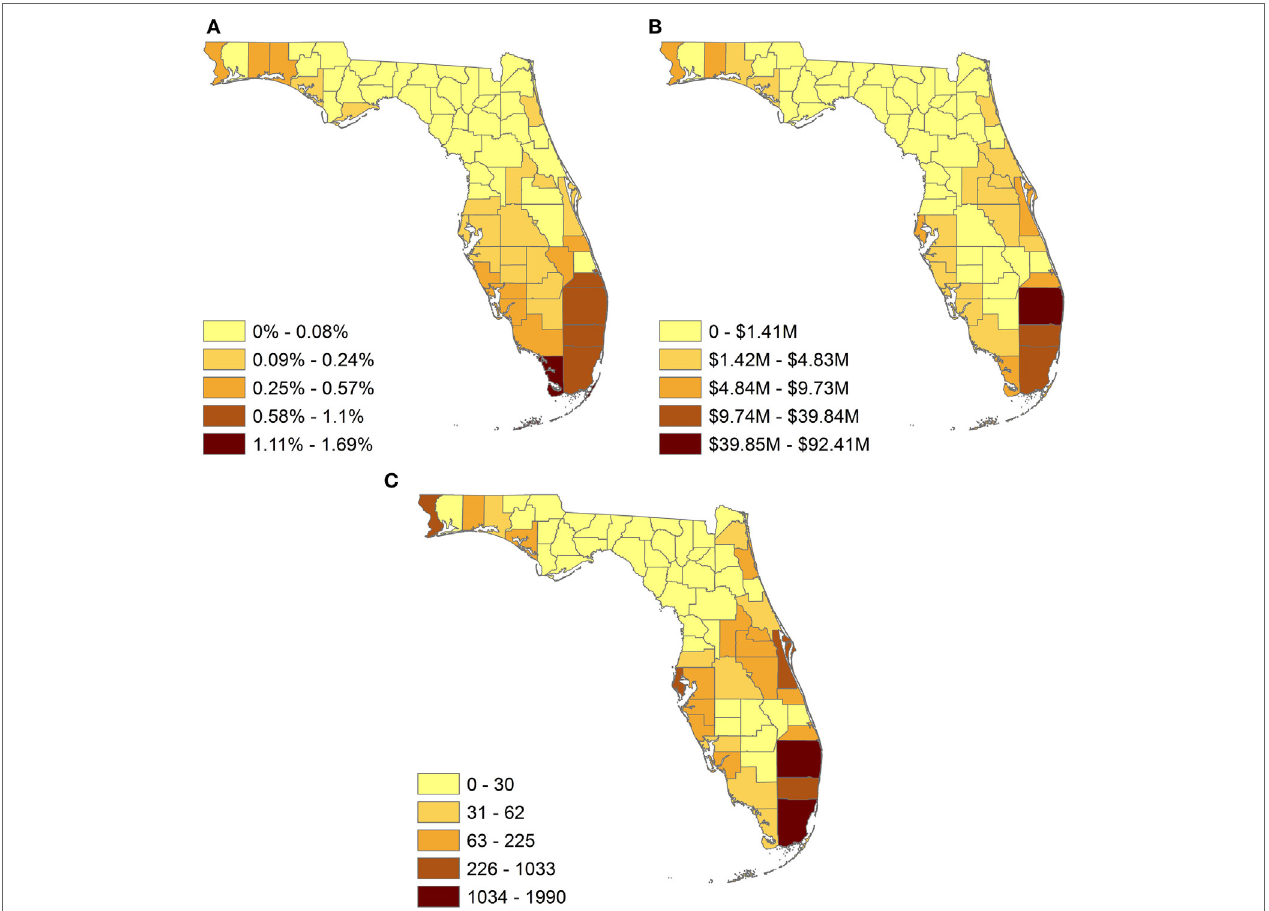
(subjective in AADP). Figure 5 defines the relationship between the AAPL and the population. The trend among points is more visible compared with Figure 4 and drawn by black dashed line. The main criteria in choosing the trend functions was the smallest coefficient of determination of the functions that satisfy the initial constrains used earlier for Figure 4 . We have chosen the linear functions for Figures 5A,C and power function for Figure 5B . The coefficients of determinations exceeded 0.91, 0.78, and